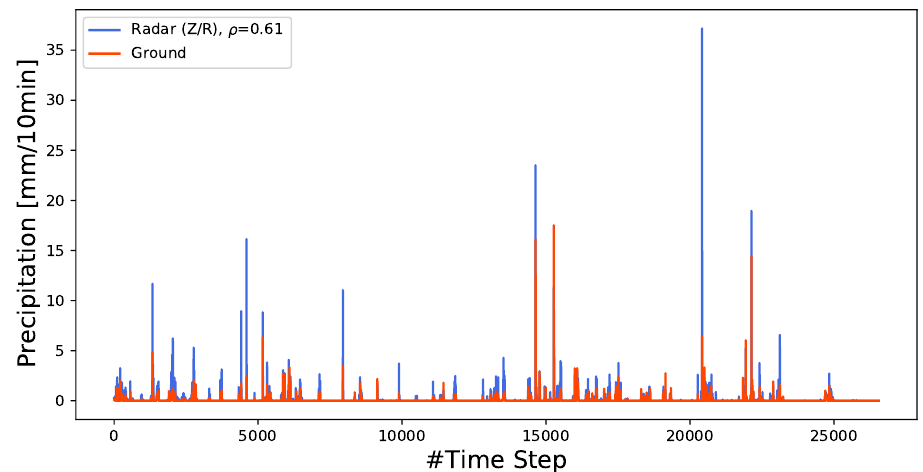
Figure 2. Observed precipitation and precipitation calculated from reflectivity by the Z – R relationship at location Hohenpeissenberg (Correlation coefficient ρ = 0.61).